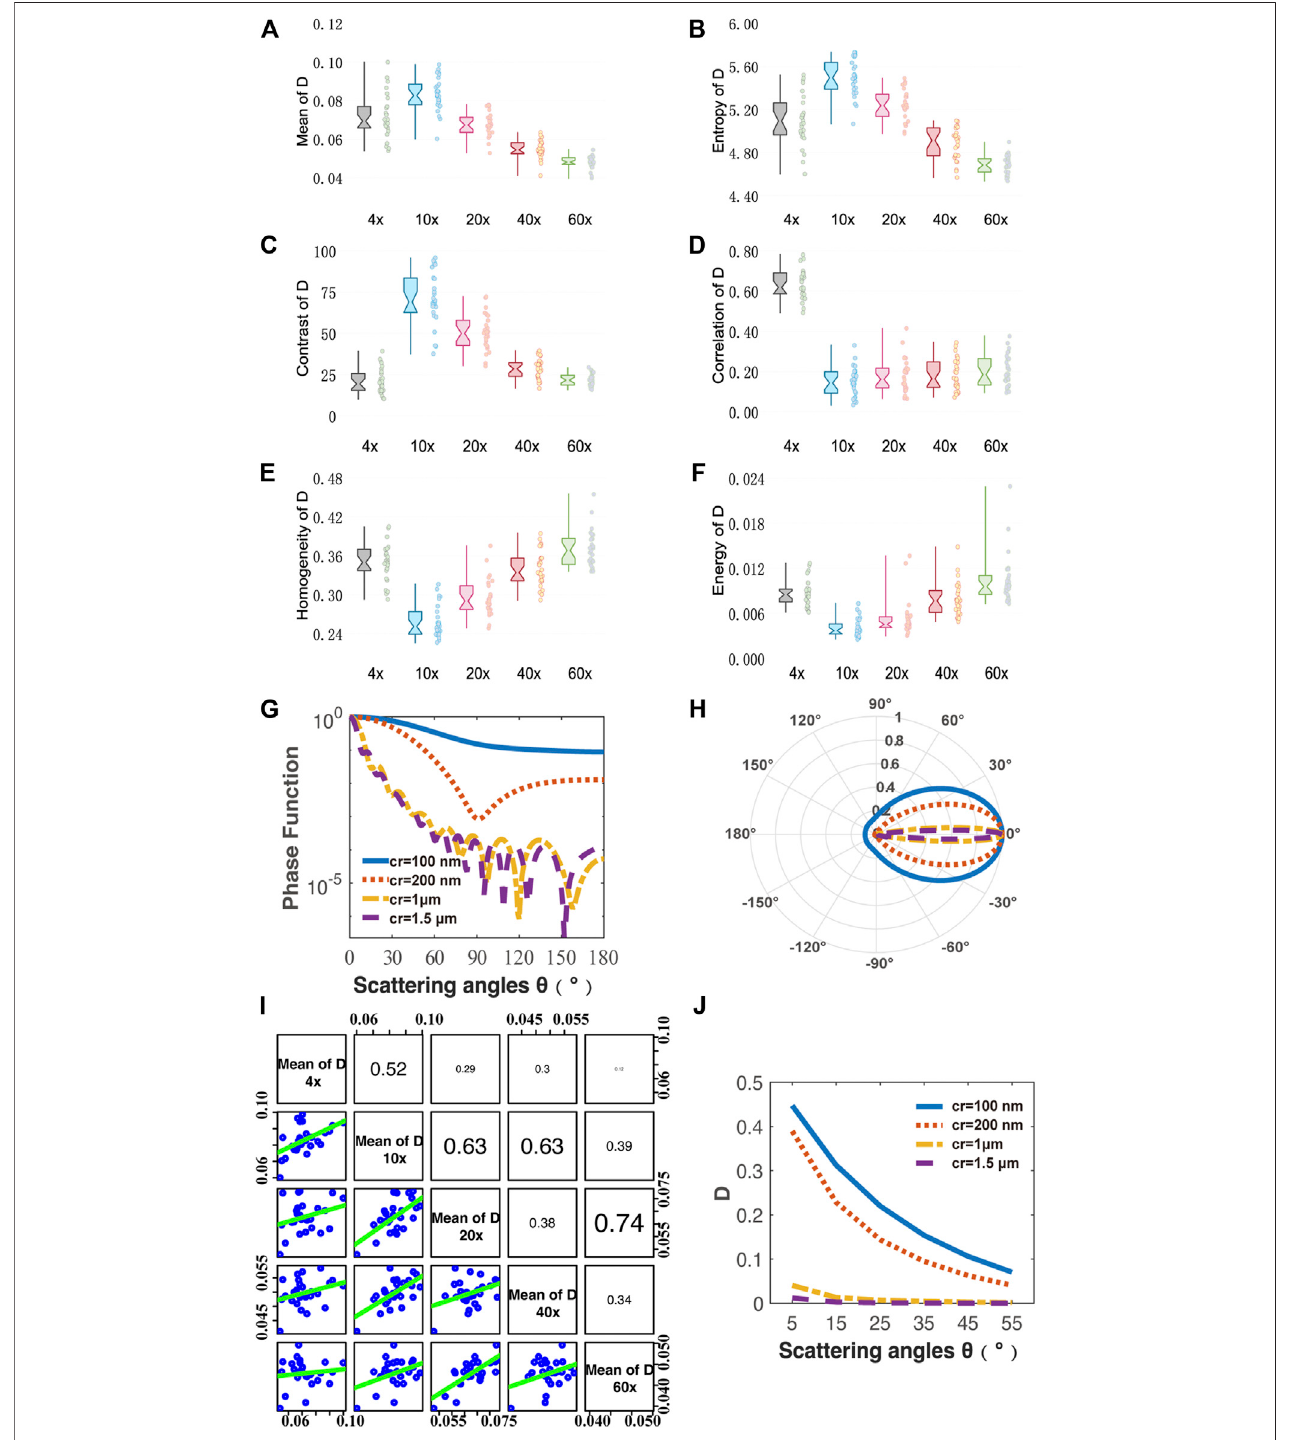
FIGURE 3 | Quantitative analysis of MMPD parameter D images under different magni fi cation objectives (4×/NA 0.10, 10×/NA 0.25, 20×/NA 0.40, 40×/NA 0.65, 60×/NA 0.80). (A – F) Box plots ofMean, Entropy, Contrast, Correlation, Homogeneity and Energy. (G,H) Phase functions for cylinder scatterers with radius of100, 200, 1, and 1.5 μ m. (I) The scatter-plot matrix illustrates the general correlation among the Mean value of D under different magni fi cation objectives (4×/NA 0.10, 10×/NA 0.25, 20×/NA 0.40, 40×/NA 0.65, 60×/NA 0.80). The variables are written in a diagonal line from top left to bottom right. On the right of the diagonal are the correlationcoef fi cient R betweentwopairsofmeanof D atdifferentmagni fi cations,withthelargerthefontsize,thehigherthecorrelation.Ontheleftsideofthediagonalis the scatter-plot matrix, with smooth green trend line to illustrate the underlying relationship. (J) Monte Carlo simulation results of the parameter D using the cylinder scatterer model of different radius: 100, 200, 1, and 1.5 μ m. The horizontal axis represents different scattering angle from 5 ° to 55 ° .